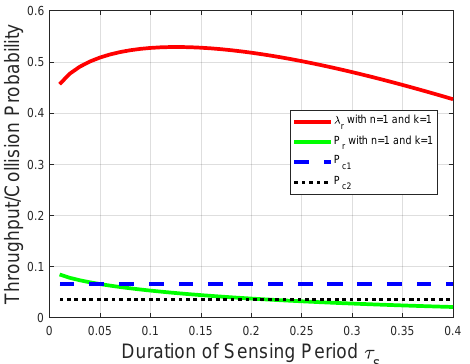
Figure 6. Throughput and collision performances of the CRN with a given reporting period, n = 1, and k =